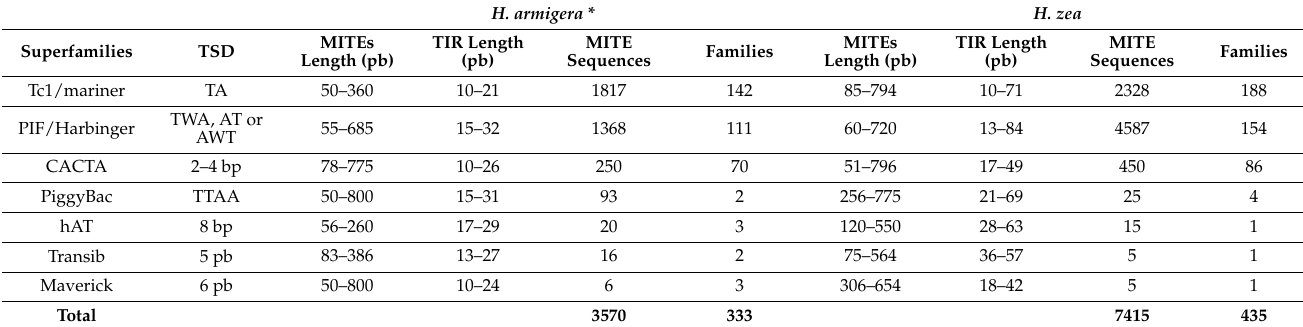
Table 1. MITE superfamilies detected in H. armigera and H. zea